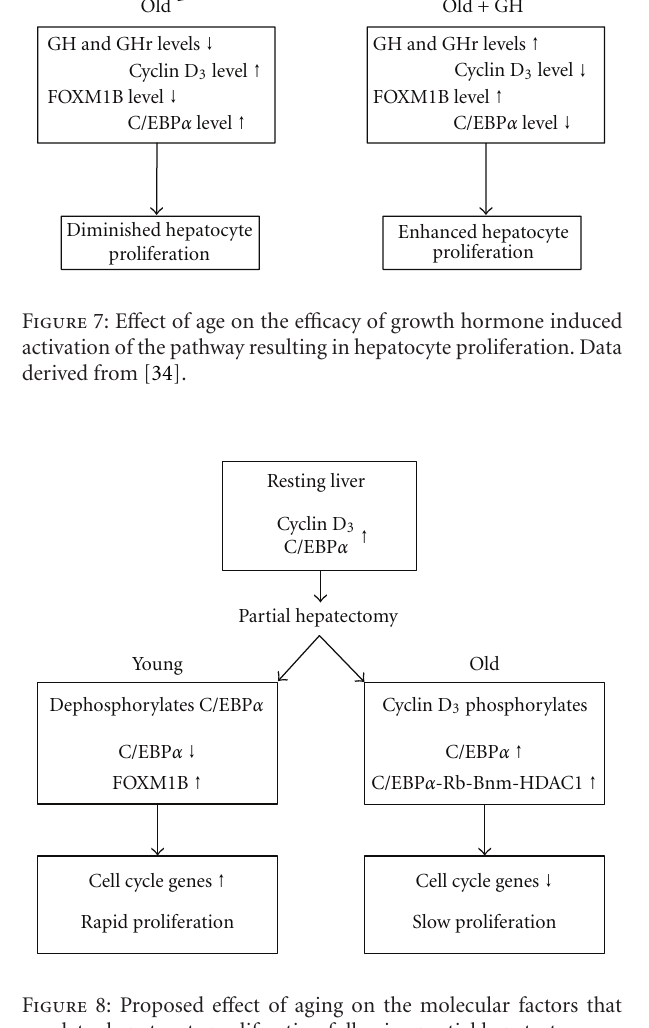
Figure 8: Proposed e ff ect of aging on the molecular factors that regulates hepatocyte proliferation following partial